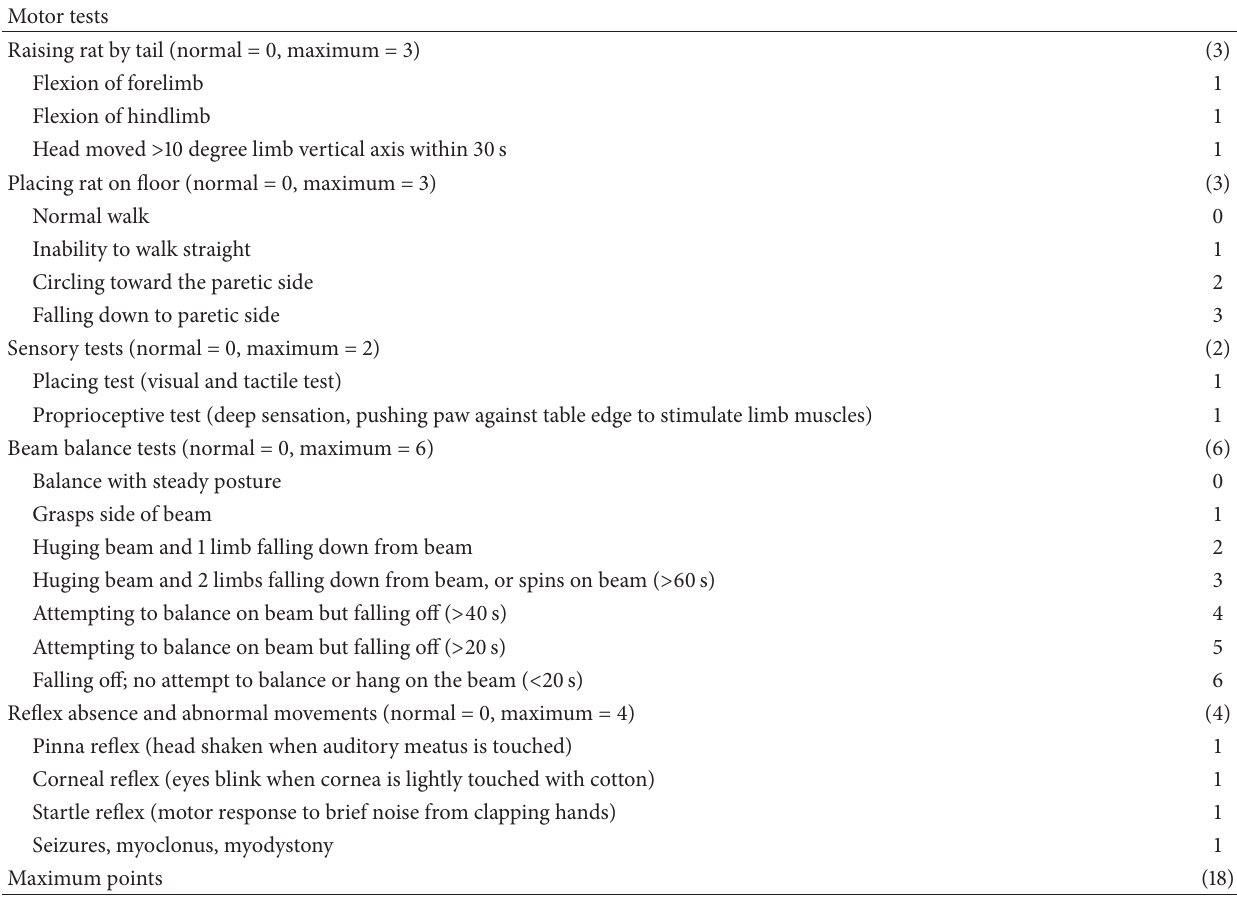
Table 1: Detail description of the items forming the modified neurological severity score